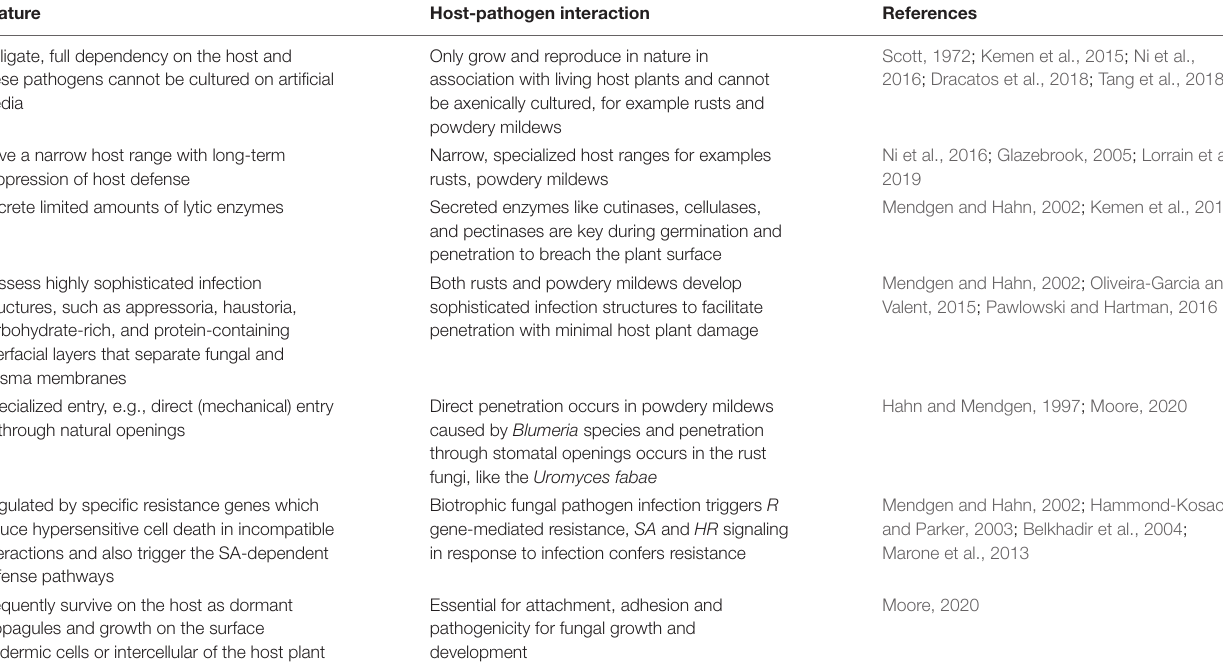
TABLE 1 | Characteristics of the obligate biotrophic plant pathogenic fungi.